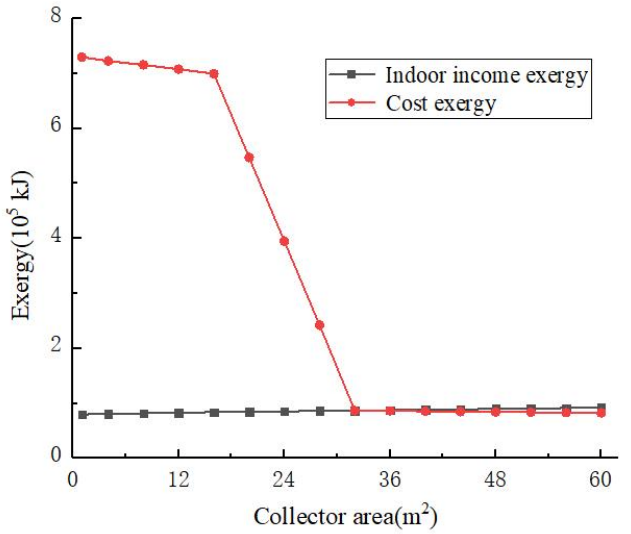
Figure 5. Variations of the cost and indoor income exergies with the area of the solar collector.